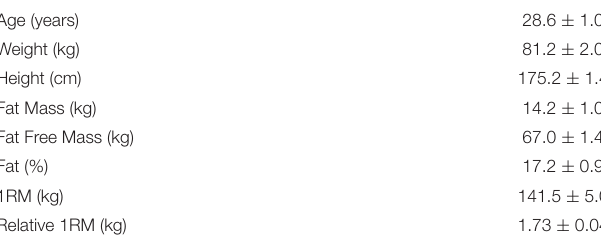
TABLE 2 | Participant characteristics (means ± standard error of the